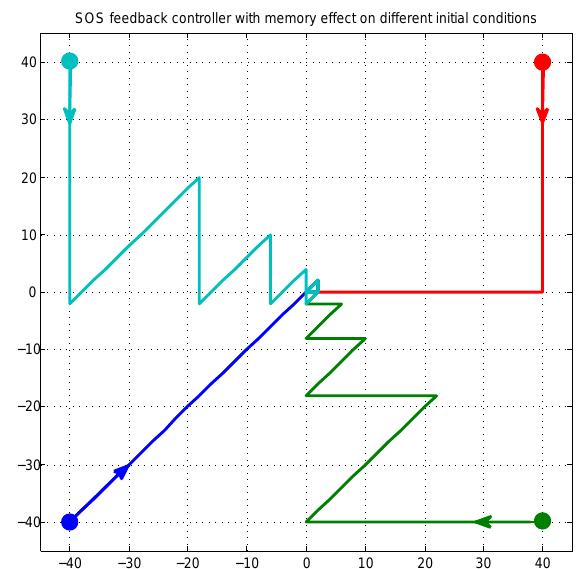
Figure 6: Simulation results of the sector-of-sight feed- back controller for deep-sea scenario, with memory